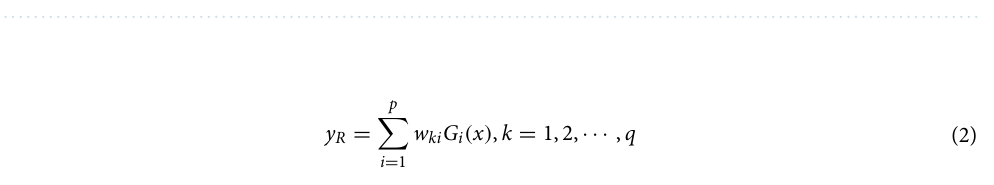
Table 3. Comparison of the actual value of cylinder hole verticality and RBF predictive